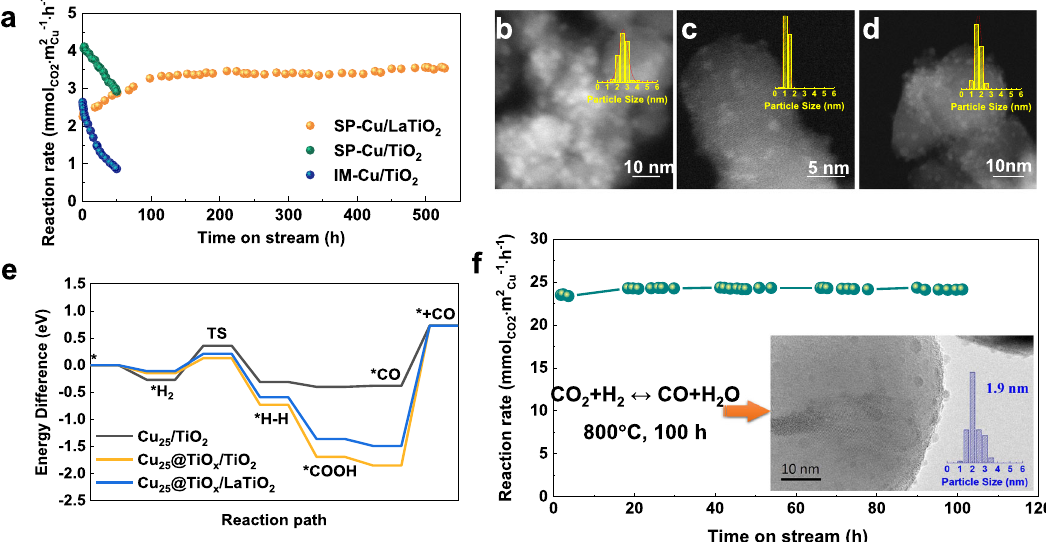
Fig. 2 Thermal stability of Cu-based catalysts at high temperatures. a Stability tests in RWGS reaction at 600 °C over IM-Cu/TiO 2 , SP-Cu/TiO 2 , and SP- Cu/LaTiO 2 samples. b – d ADF-STEM images and particle size distributions of b SP-Cu/LaTiO 2 -500R, c SP-Cu/LaTiO 2 -100h, and d SP-Cu/LaTiO 2 -500h catalysts. e Comparison of the RWGS reaction path over three models from DFT calculations. f Long-term thermal stability of SP-Cu/LaTiO 2 at 800 °C. Inset was the TEM image and the distribution of Cu nanoparticles of the used